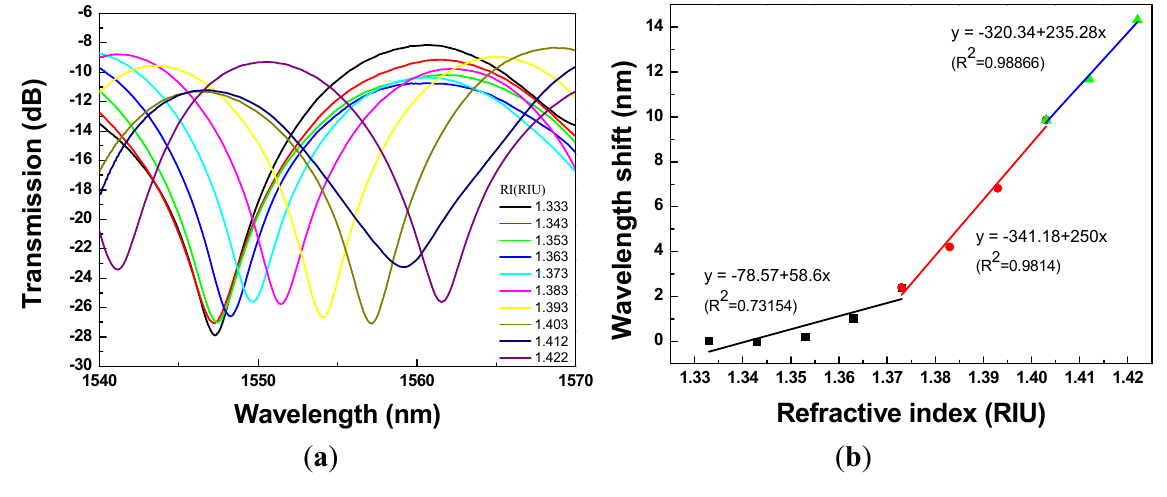
Figure 9. A 2.67-cm PCF interferometer with: ( a ) the transmission spectra for sensing different refractive indices of the sucrose solution (RI = 1.333 − 1.422); ( b ) the relationship between wavelength shift and refractive index (resonance wavelength = 1,547.26